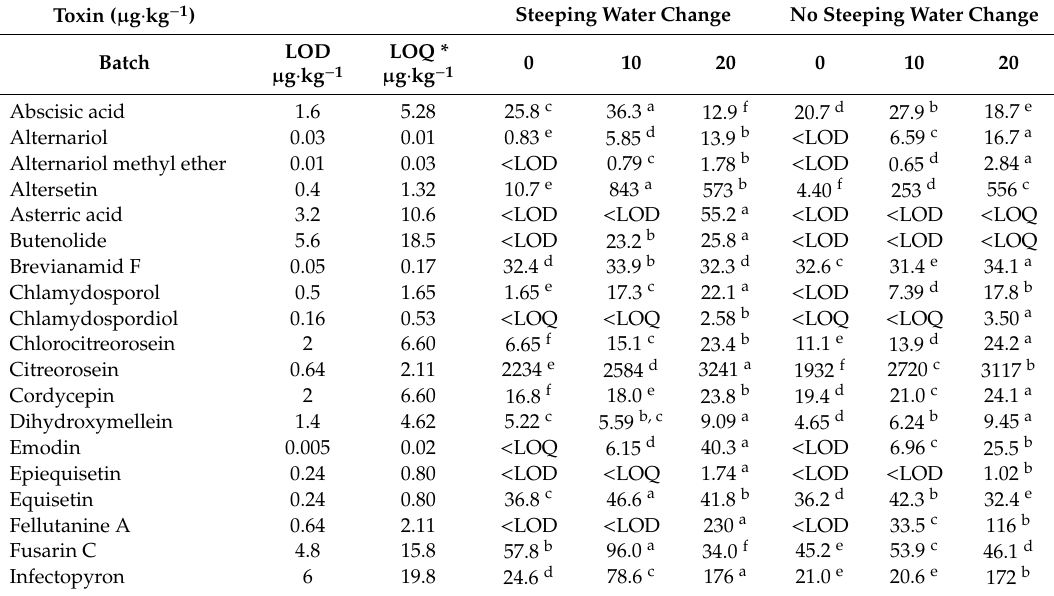
Table 5. Concentrations of other positively-identified mycotoxins / fungal metabolites in malt samples. Toxin ( µ g · kg − 1